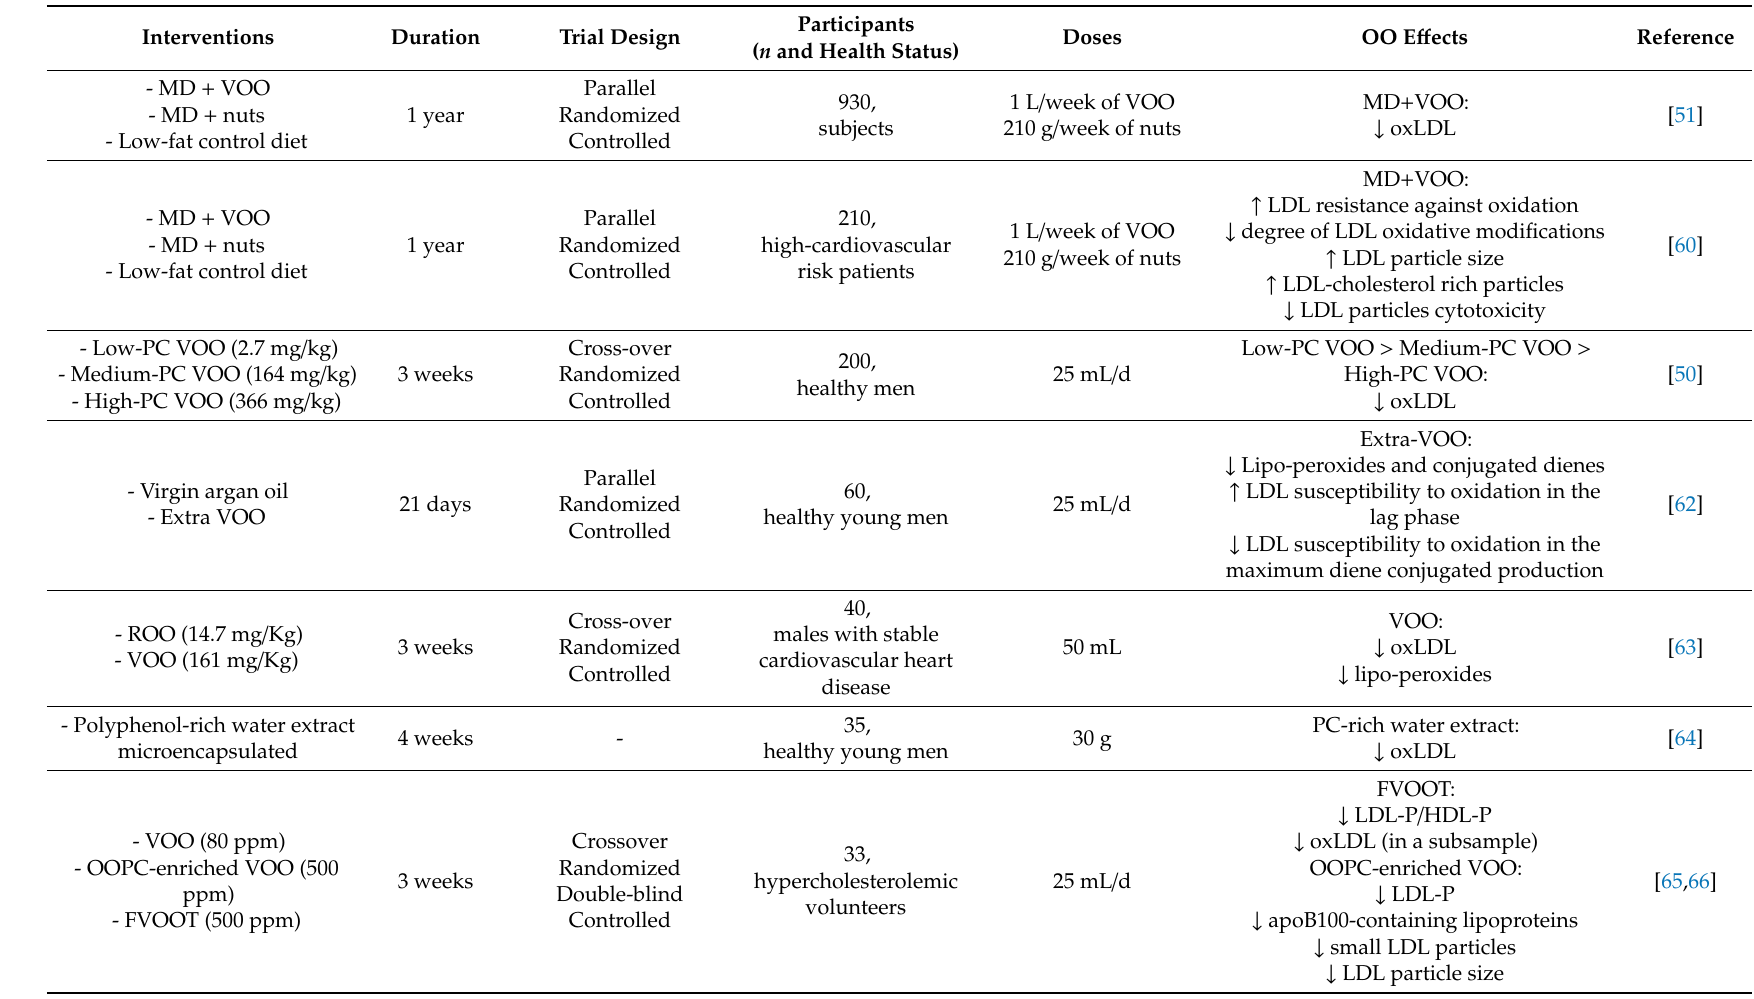
Table 2. Clinical trials which analysed the e ff ects of VOO and phenol-enriched VOO on LDL